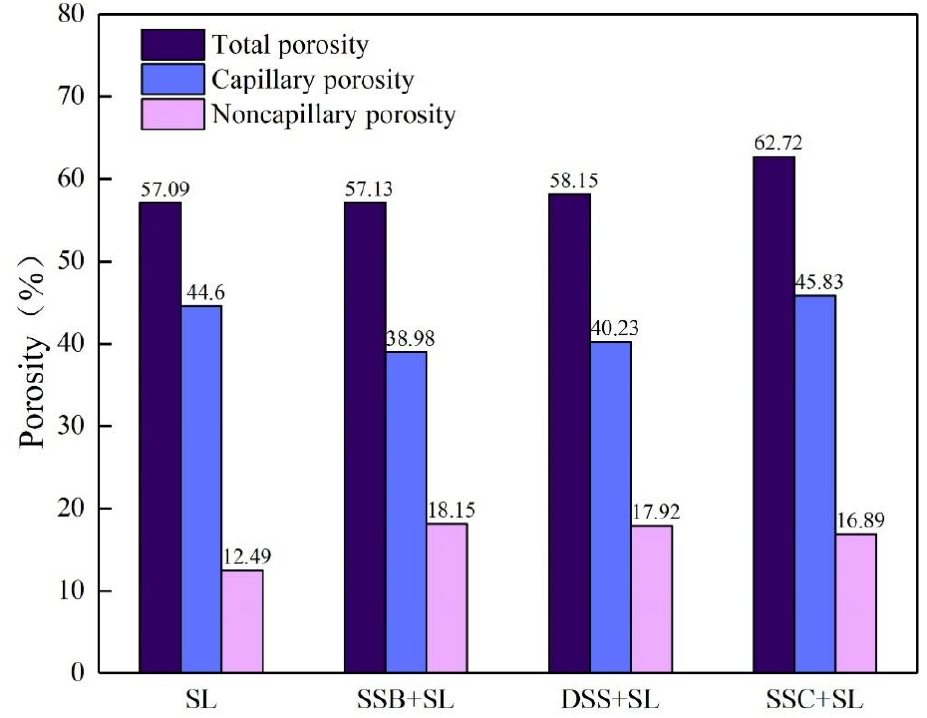
Figure 2. Comparison of three porosities (total porosity, capillary porosity and non-capillary porosity) for four different samples (SL, SSB + SL, DSS + SL, SSC + SL).